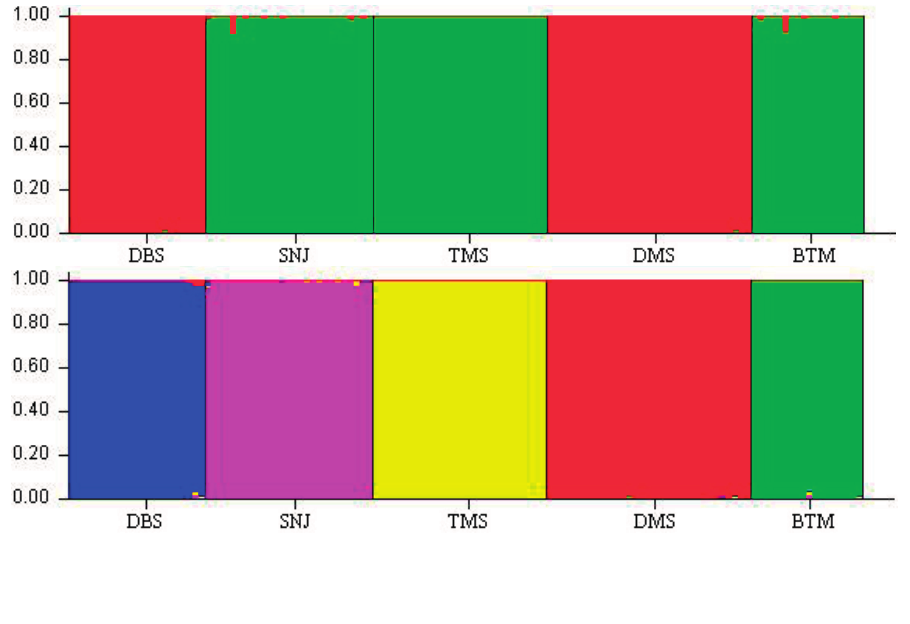
Figure 6. Population structure of six populations of C. japonicum prepared using the STRUCTURE program when K = 2 ( above ) and K = 5 ( below